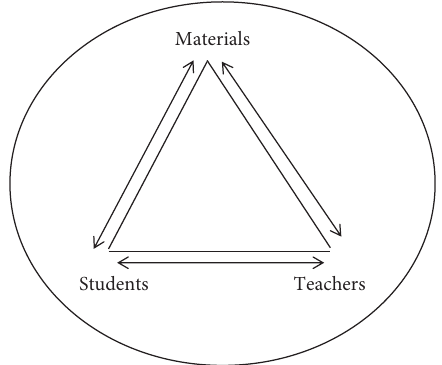
Figure 1: Instructional capacity building and quality education (source: